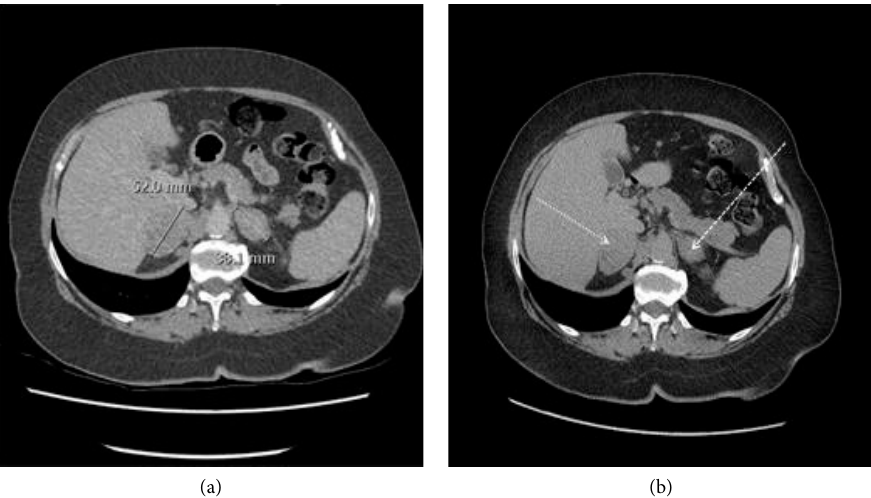
Figure 1: Initial pre- and postcontrast CT image (axial) demonstrating bilateral adrenal metastases (arrows). Nonenhanced CT imaging is actually very helpful because it can dismiss the lesions as benign adenomas.